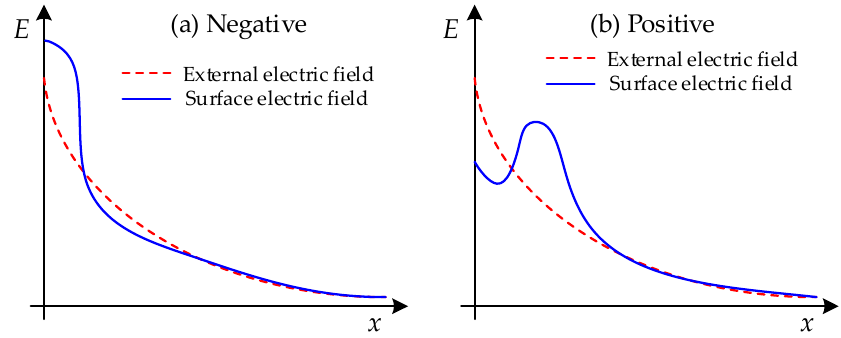
Figure 14. Electric field distribution at a low pressure with different polarities.